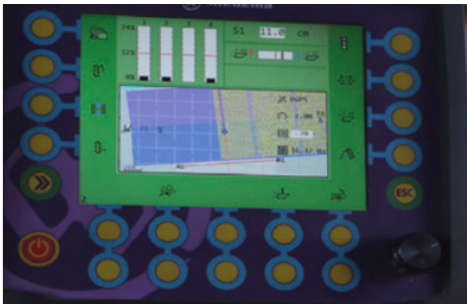
Figure 30. HMI operator terminal. Reprinted with permission from ref. [12]. Copyright 2021 Double L Industries.